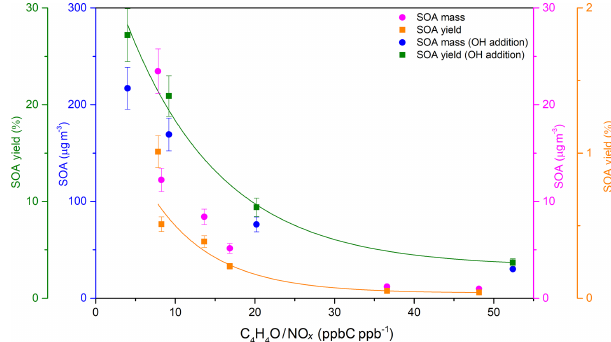
Figure 3. Dependence of the SOA mass concentration and SOA yield on the C 4 H 4 O / NO x ratio. Since the particle wall loss has a weak RH dependence in our chamber, a mean value of 3 . 6 × 10 − 5 s − 1 was used for wall loss correction. A density of 1.4gcm − 3 was used in SMPS (Jia and Xu, 2018; Kostenidou et al., 2007).